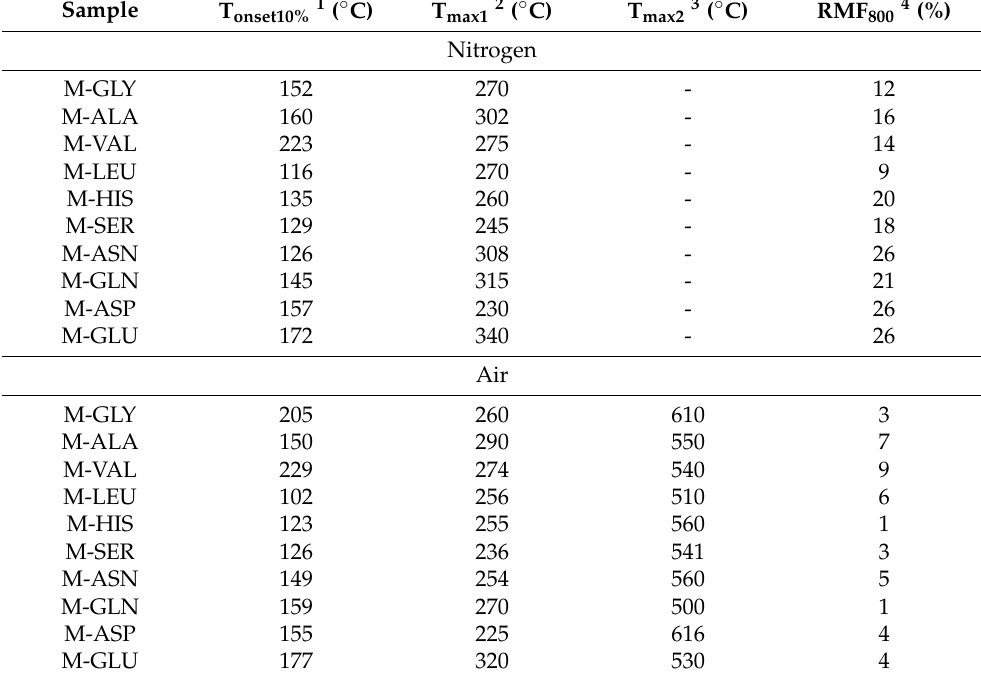
Figure 1. TG thermograms of α -amino acid-derived PAAs in nitrogen ( a ) and air ( b ). Table 3. Thermal data of α -amino acid-derived PAAs in nitrogen and air by thermogravimetric analysis.